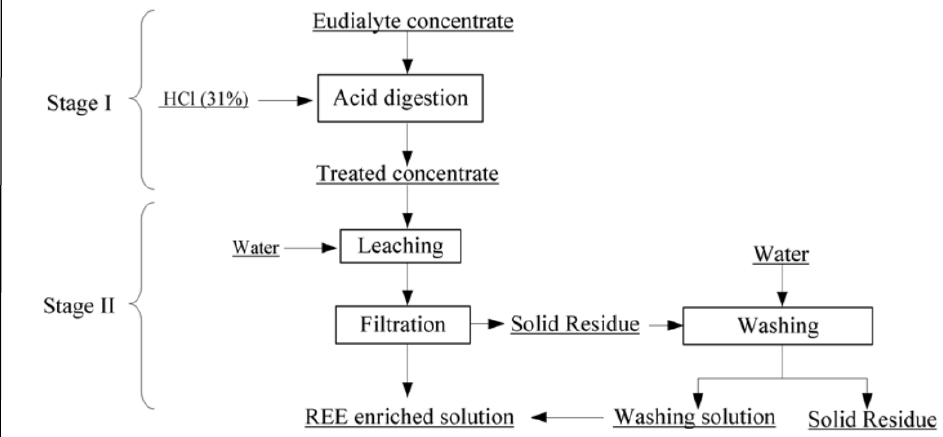
Figure 3 – Avoiding silica gel formation using the dry digestion process for the eudialyte treatment (Ma et al, 2018,